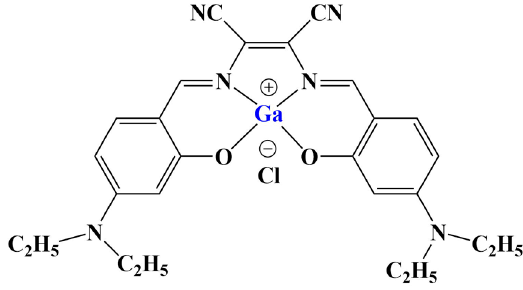
Figure 19. One of the complexes presented in [9].